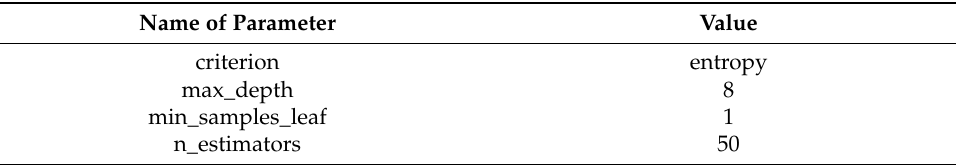
Table 4. Hyper-parameters of the RandomForestClassifier